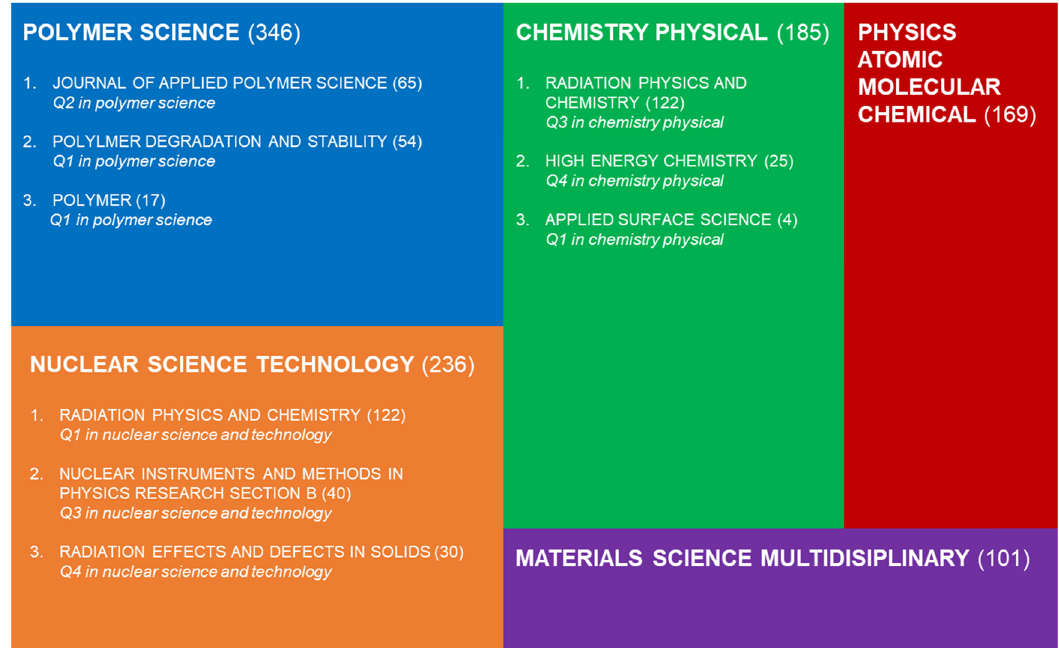
Figure 2: First fi ve WOS categories of the whole research. The fi rst three journals for each category are